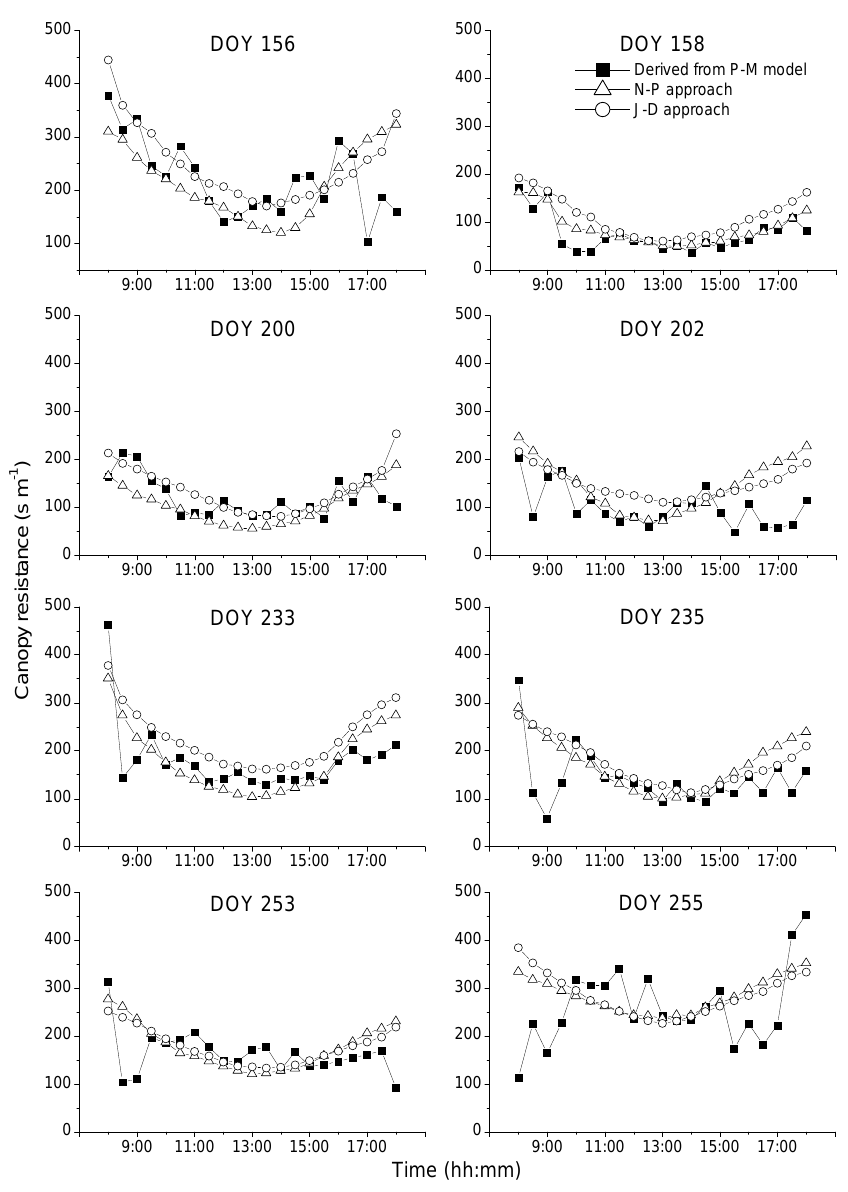
Fig. 6. Comparison of the measured and the simulated half-hourly bulk canopy resistance on the days before and after irrigation during the maize growing